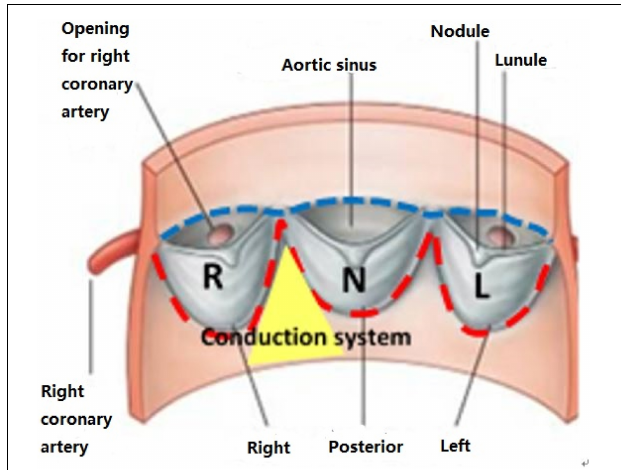
FIGURE 1 | Conduction system zone.